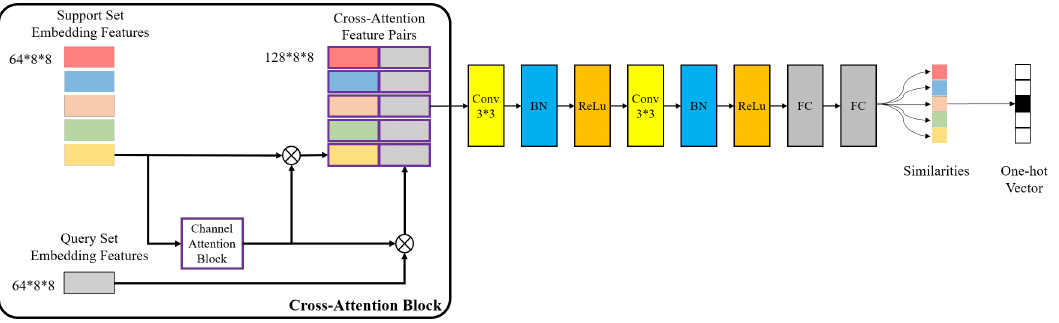
Figure 6. Cross-attention metric